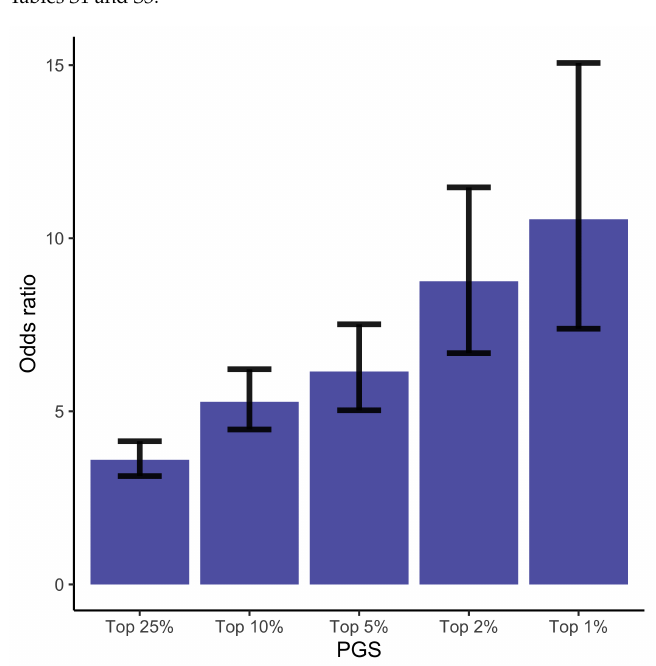
1 Table with top most significant SNPs from the polygenic risk score as the result of machine-learning procedure. SNPs are annotated using SNPnexus . Full Table with all 84 SNPs and their weights is available in Supplementary Tables S1 and S3.